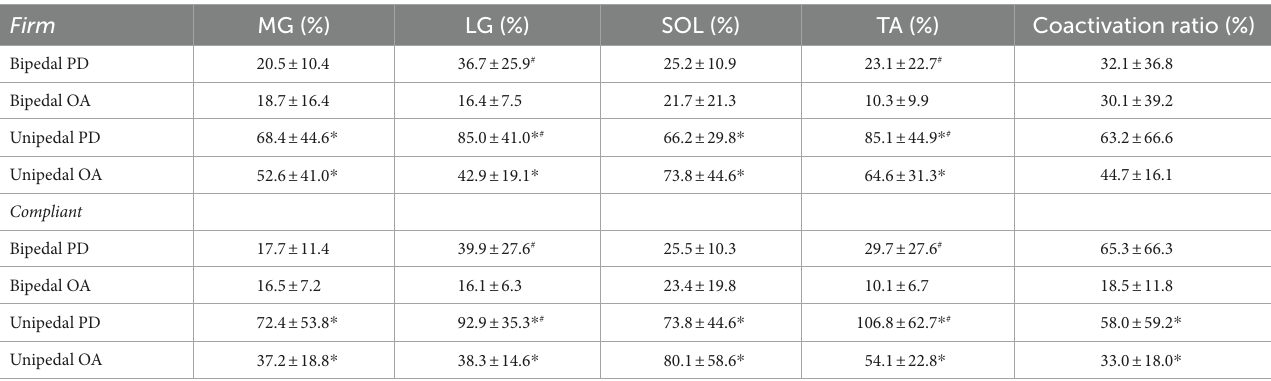
Values are root mean squared EMG normalized to their respective maximum value during plantar flexion (MG, LG, SOL) or dorsiflexion (TA) MVC and expressed as percentages. Coactivation ratio was calculated by dividing the normalized TA activation by the sum of the normalized plantar flexors EMG and multiplying by 100. PD, older adults with Parkinson’s disease; OA, healthy older adults. MG, medial gastrocnemius; LG, lateral gastrocnemius; SOL, soleus; TA, tibialis anterior. *, differs from bipedal stance for same surface condition ( p < 0.001). #, differs between older adults with PD and health older adults within same stance and condition ( p <